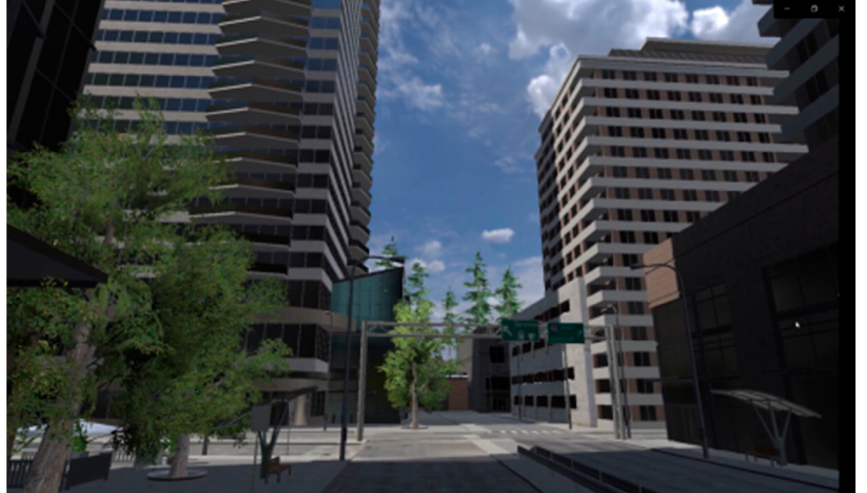
Figure 4. Screenshot 1 of an urban